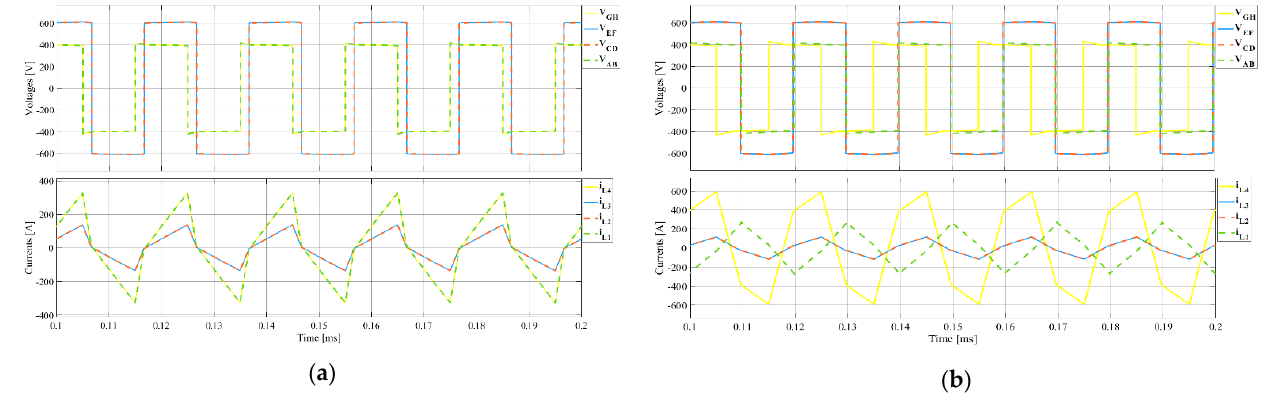
Figure 12. Voltage and current waveforms at the transformer windings: ( a ) P 1 = P 2 = P 3 = P 4 = 50 kW; ( b ) P 1 = 33.3 kW, P 2 = P 3 = 33.3 kW, P 4 = 100 kW.